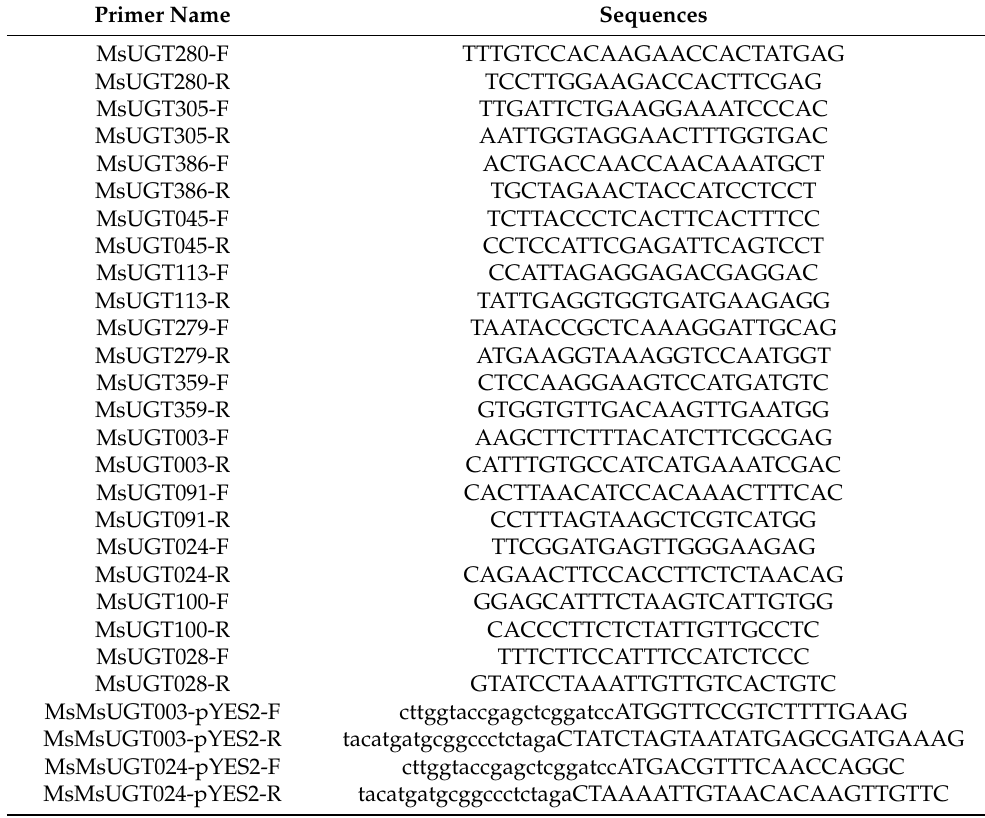
Table 1. Primers used in this